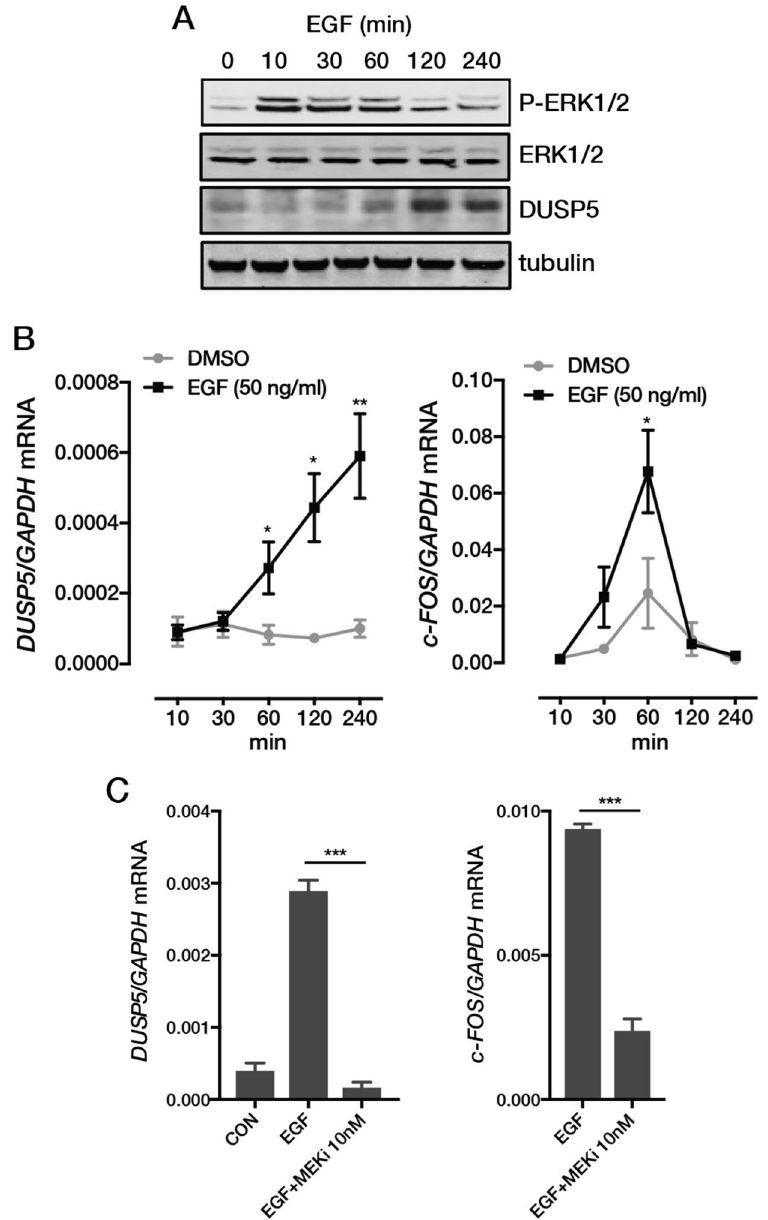
Figure 2. Induction of DUSP5 by EGFR-ERK signalling in CRC cells. Time-course showing EGF-mediated induction of ( A ) p-ERK1/2 and DUSP5 protein expression, and ( B ) DUSP5 and c-FOS gene expression in LIM1215 cells. ( C ) Induction of DUSP5 and c-FOS mRNA by EGF requires MEK/ERK signalling. LIM1215 cells were stimulated with EGF (50 ng/ml) for 24 h in the absence or presence of the MEK inhibitor (MEKi) trametinib. * P < 0.05, ** P < 0.005, * P <